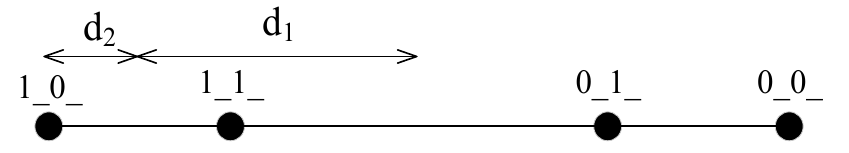
Figure 3. 4/16-QAM modulated in-phase subflow. Figure 3. 4/16 ‐ QAM modulated in ‐ phase subflow. According to the document [18], the bit error rate of high-priority data from source node S i to relay node R can be expressed